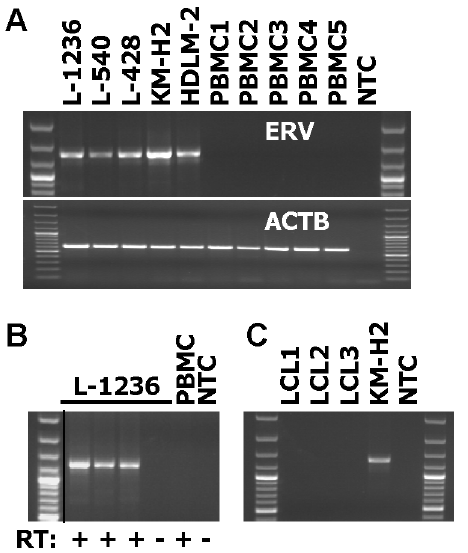
Figure 3. Expression of ERVK_1q42.13 in HL cell lines. (A) Presented are results from a RT-PCR with primers with specificity for actin beta (ACTB) and ERVK_1q42.13. cDNA from HL cell lines and normal PBMC was used as template for PCR. NTC: no template control. (B) Presented are results from a RT-PCR with primers with specificity for ERVK_1q42.13. cDNA from HL cell line L-1236 and normal PBMC was used as template for PCR. cDNA was synthesized by using reverse transcriptase (RT: + ) from three different vendors (see Material and methods). In addition, RNA was used without reverse transcription (RT:- ). NTC: no template control. The black dividing line indicates removal of five irrelevant lanes from the original image. (C) Presented are results from a RT-PCR with primers with specificity for ERVK_1q42.13. cDNA from HL cell line KM-H2 and three different lymphoblastoid cell lines (LCL) was used as template for PCR. NTC: no template control. cell lines and microdissected HL cells (microarray data from the Gene Expression Omnibus (GEO) data base; Figure S3).